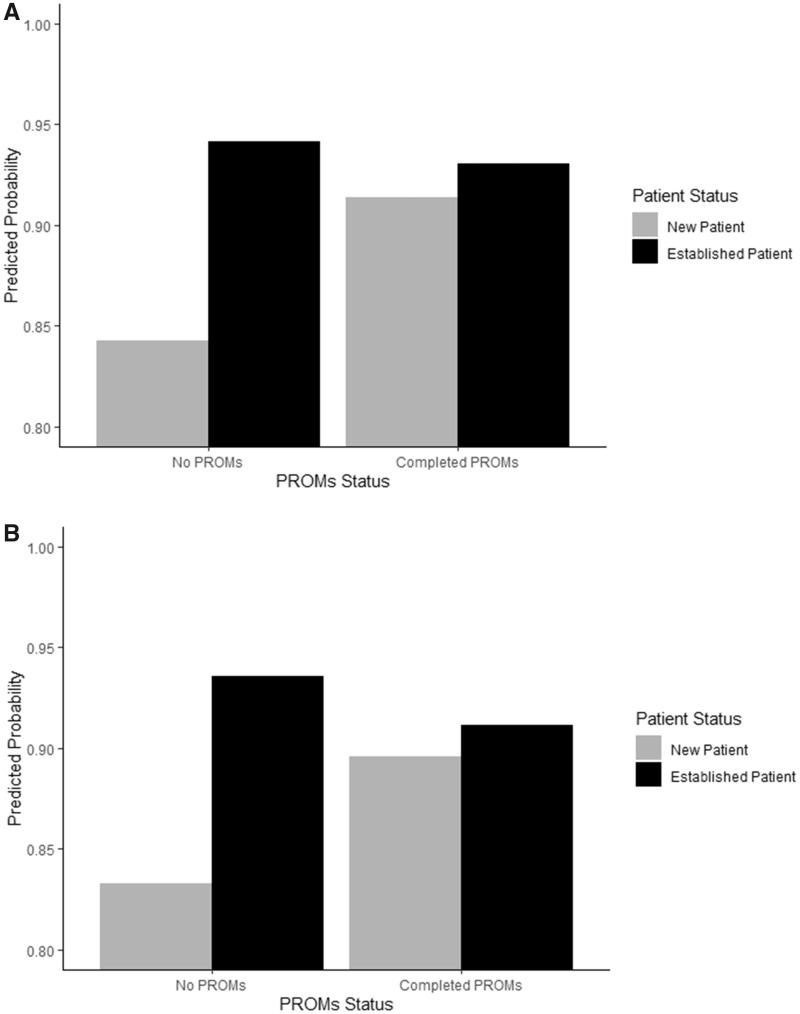
Predicted probability of satisfaction measures for patient-reported outcome measures completion status by new vs established patientsPredicted probabilities from multivariable mixed effects models (Table 4) for top box provider rating (A) and overall satisfaction with care (B) for established and new patients completing vs not completing PROMs. PROMS: patient-reported outcome measures.